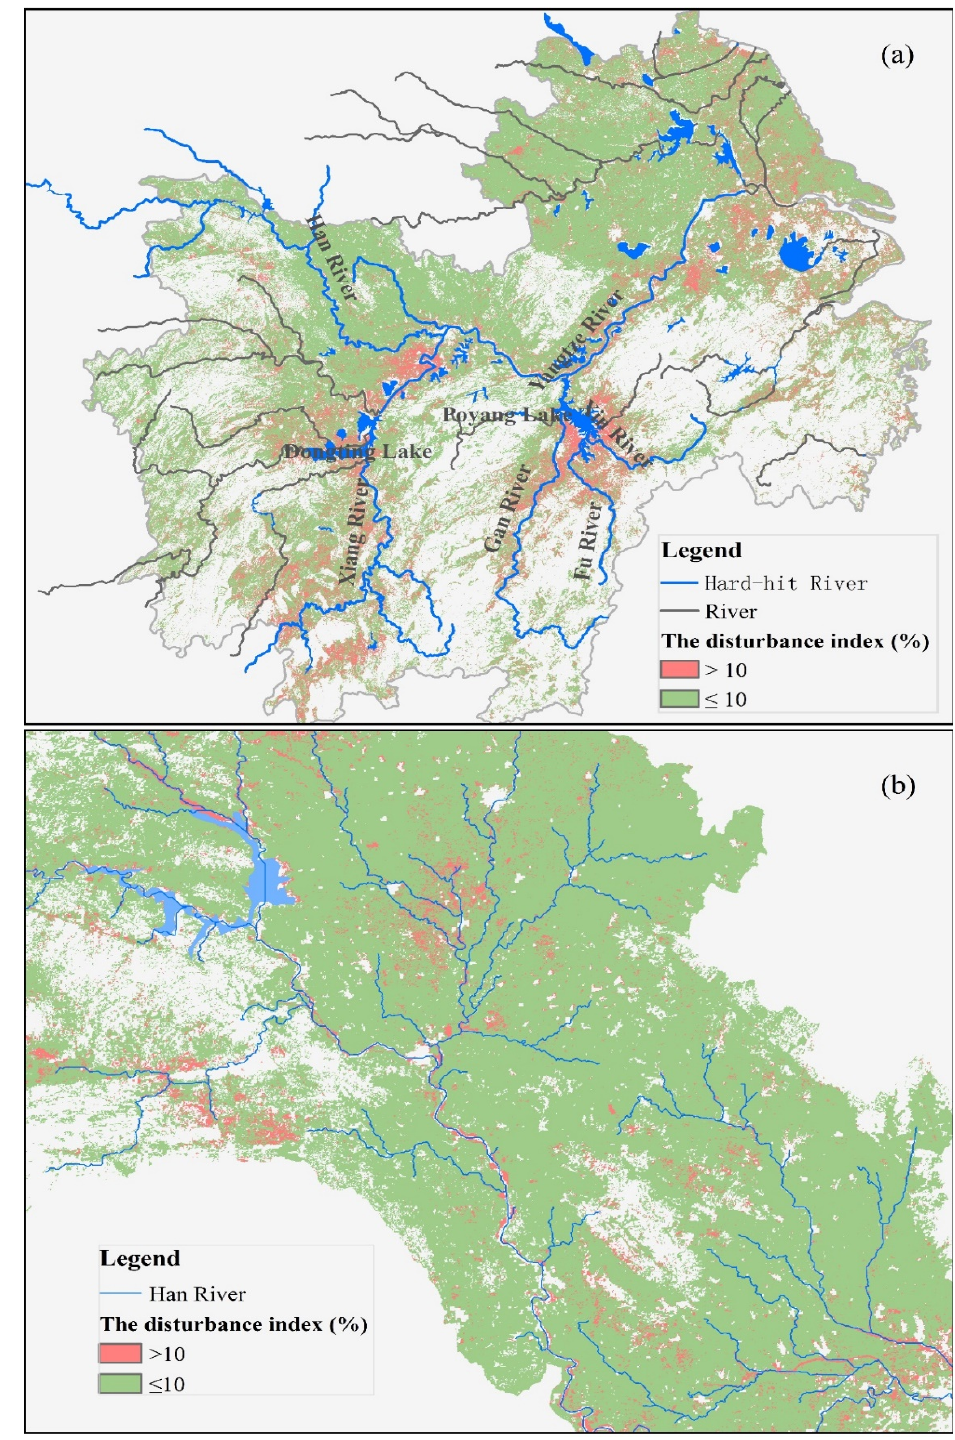
Figure 4. Flood disturbance detection results obtained from the IDI in ( a ) the middle and lower reaches of the Yangtze River Basin (MLYRB) and ( b ) the Han River Basin.